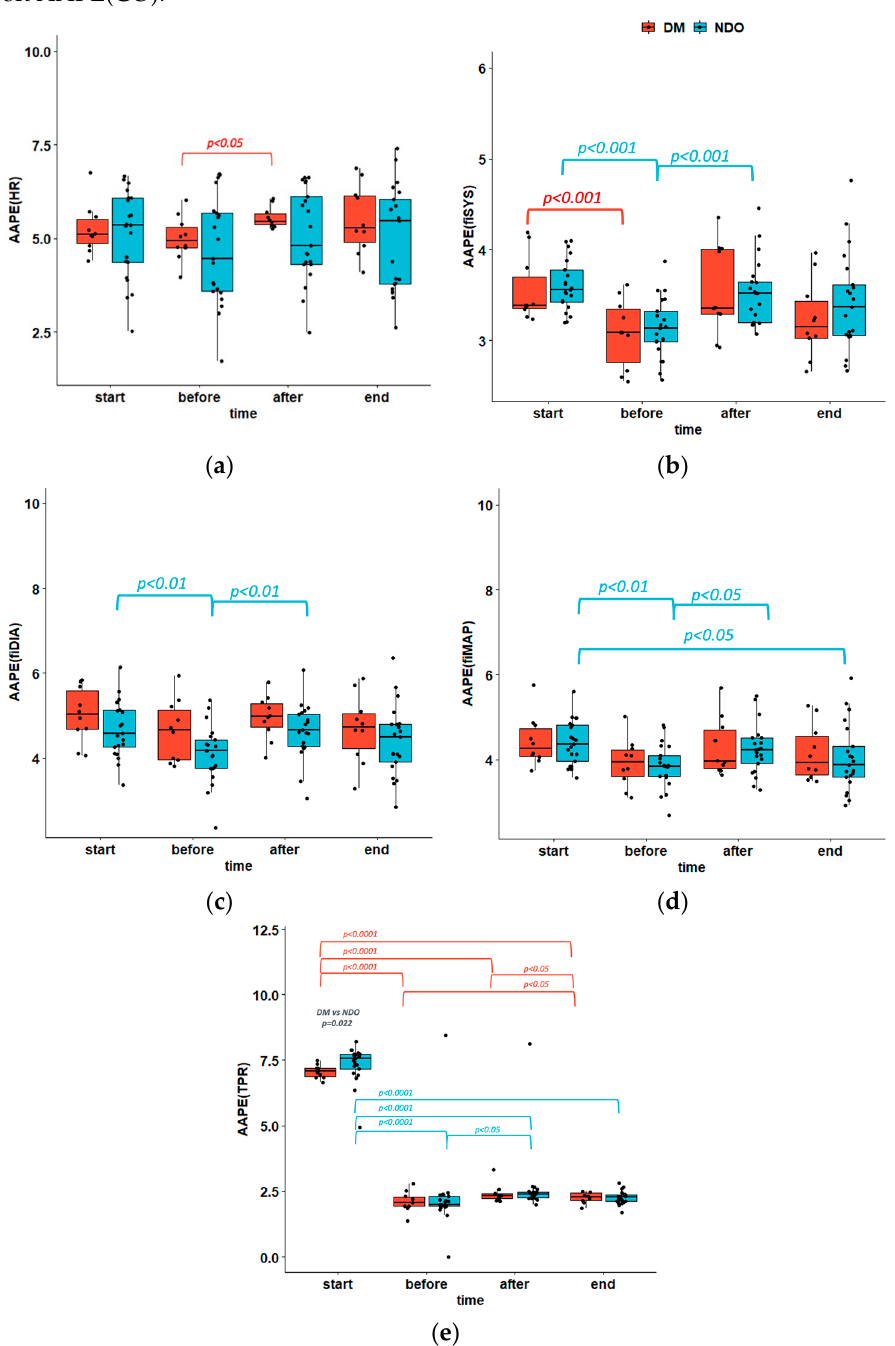
Figure 2. Amplitude aware permutation entropy of ( a ) Heart rate, ( b ) Systolic blood pressure, ( c ) diastolic blood pressure, ( d ) mean arterial pressure, ( e ) Total peripheral resistance.